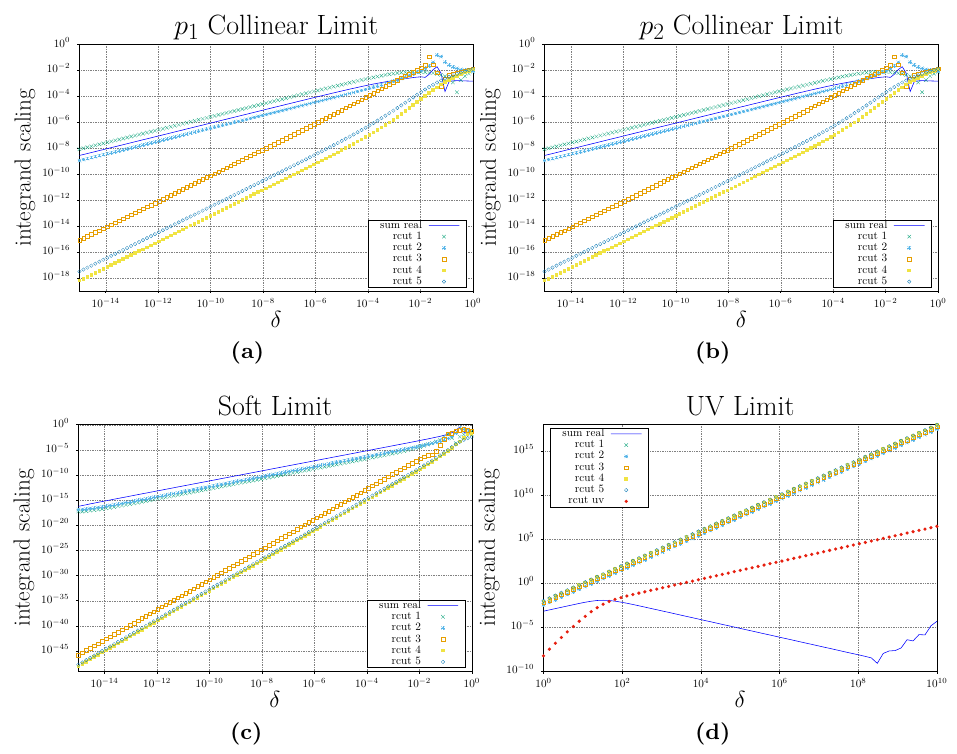
Figure 16. Behaviour of the q (cid:22) q 3 (cid:13) in the di(cid:11)erent regulated limits. When the various limits ! are approached linearly in (cid:14) the plots (a{b) show a scaling as (cid:14) 1 2 whereas (c) goes like (cid:14) 1 and (d) as (cid:14) (cid:0) 1